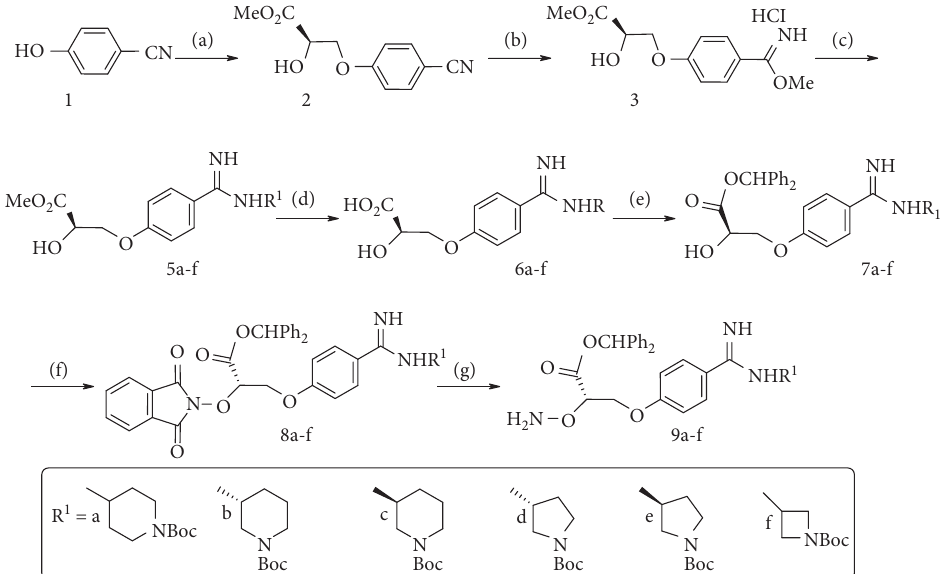
Scheme 1: Synthesis of compounds 9a – f. Reagents and conditions: (a) methyl ( R )-oxirane-2-carboxylate, (salen)Co(III) complex, 4 ˚A molecular sieves, MTBE, rt, 81%; (b) H 2 (gas), dry MeOH, 0 ° C – rt, 82%; (c) triethylamine, H 2 N-R a-f , MeOH, 0 ° C –rt, 57–95%; (d) NaOH, THF-water, 0 ° C, 75–99%; (e) Ph 2 CN 2 , CH 2 Cl 2 , rt, 31–84%; (f) PhthN-OH, DEAD, PPh 3 , THF, rt, 33–66%; (g) NH 2 NH 2. H 2 O, EtOH, rt,